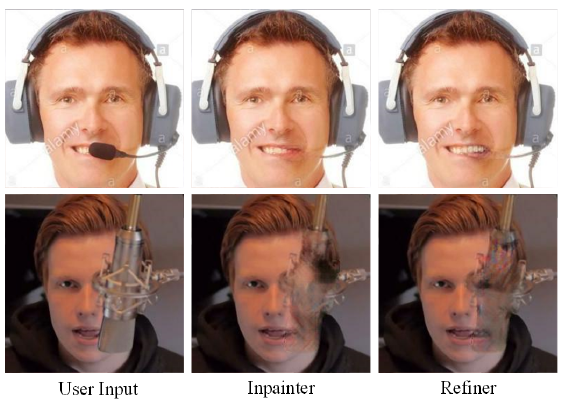
Figure 6. The performance of MRGAN for real images with overhead and headset microphones. Our training dataset does not contain overhead and headset microphone